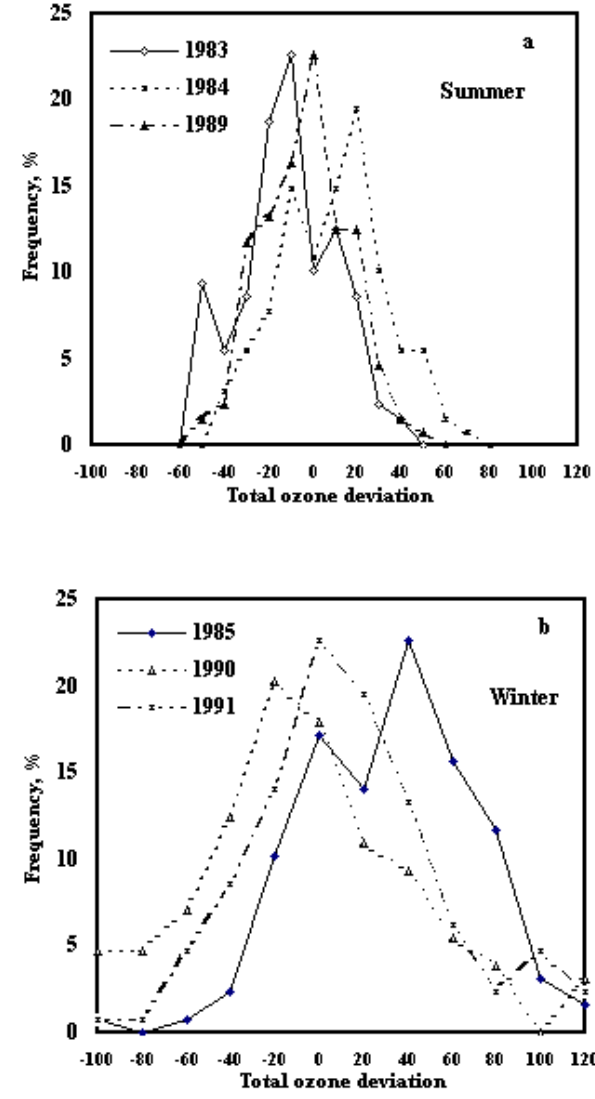
Fig. 2. Examples of frequency distributions of total ozone deriva- tions from the long-term mean (a) in the summer seasons and (b) in the winter/spring seasons